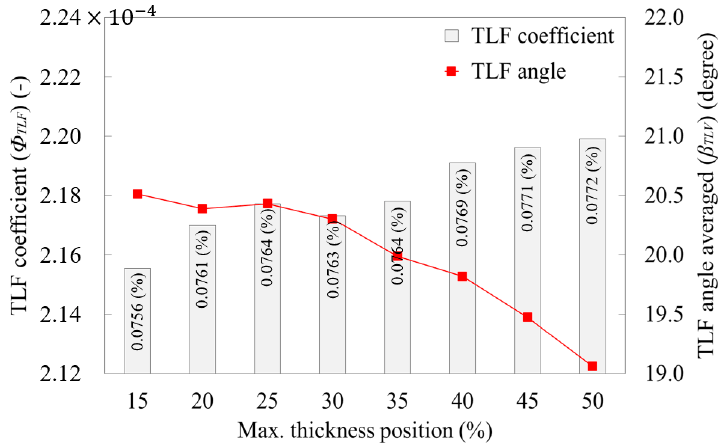
Figure 18. Flow rate and flow angle through the tip clearance with different maximum thickness positions ( 𝛷/𝛷 (cid:3031)(cid:3032)(cid:3046) = 1.0 ). Table 3. Area and velocity components on the meridional plane for tip clearance ( 𝛷/𝛷 (cid:3031)(cid:3032)(cid:3046) = 1.0 ). Max. Thickness Position (%)